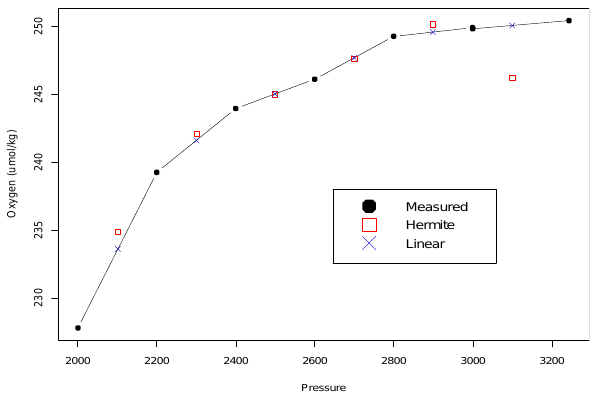
Figure 3. Illustration of interpolation. The black dots are measured data. The red boxes and blue x’s are interpolated values at the in- dicated pressures using the Hermitian and linear fitting functions, respectively. Note that there are two measurements near 3000dB and that these measured values are very nearly identical. The close proximity (in pressure) of these two measurements causes the Her- mitian fitting function to “ring” thus producing the errant interpo- lated value near 3100dB. In cases such as this, when the two fitting functions produce results that di ff er by more than 1%, the linear in- terpolation is used. For all the other cases shown the di ff erence is less than 1% and the approximation from the Hermitian function is used. All of the interpolated points shown in this example pass the “maximum measured data separation distance” test described in the text and in Table